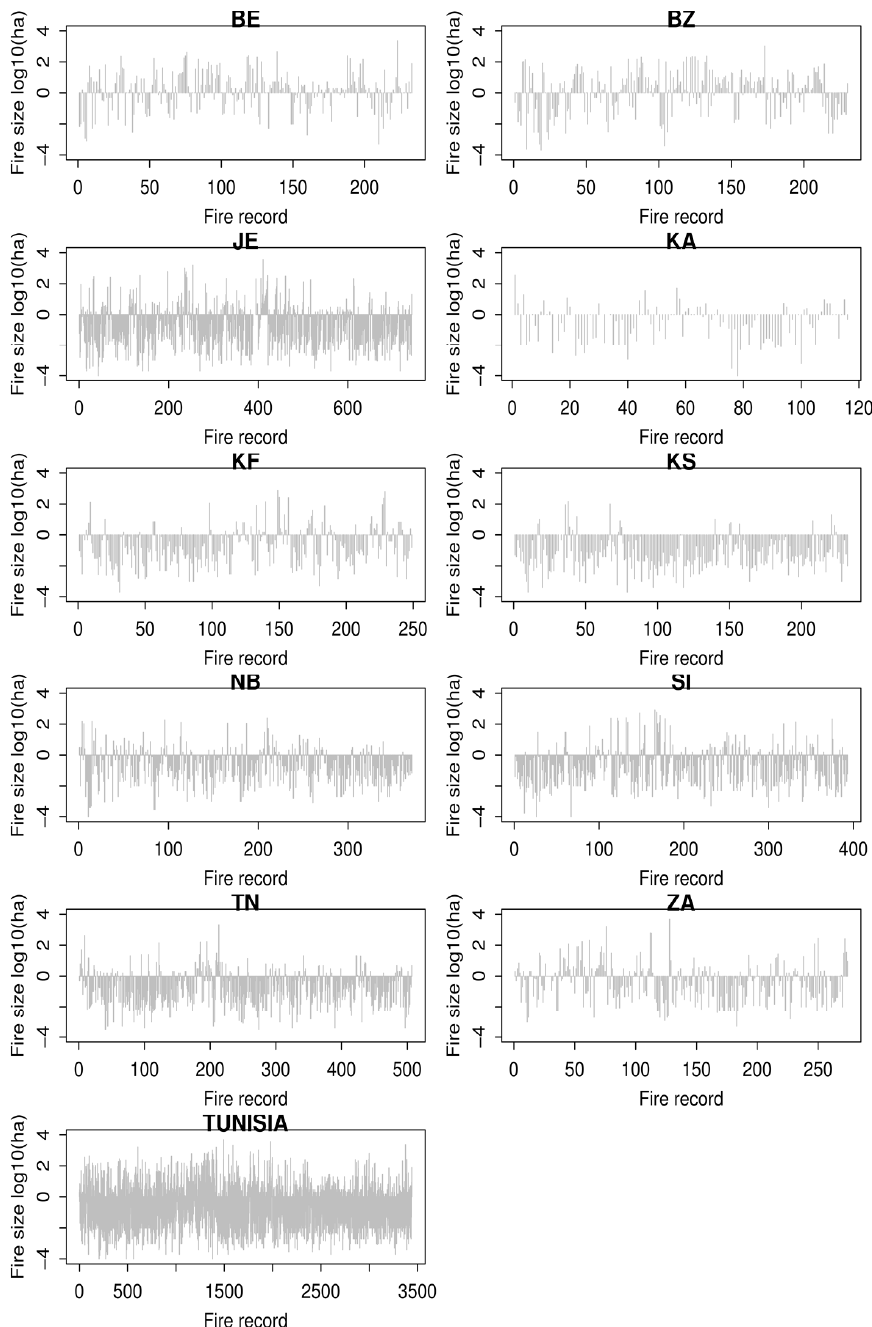
Figure 4. Size (in ha, log scale, on Y -axis) of each fire record ( X -axis, fire record identification number, classified from the oldest to the most recent), for each gouvernorat and for Tunisia as a whole.